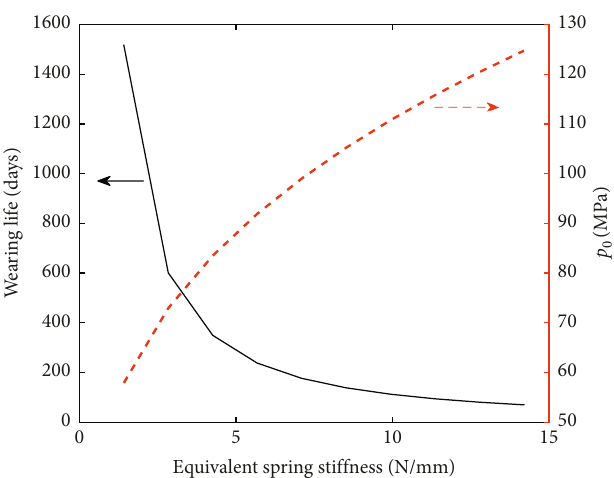
Figure 12: Wear life (left) and the maximum contact pressure (right) with the equivalent spring stiffness